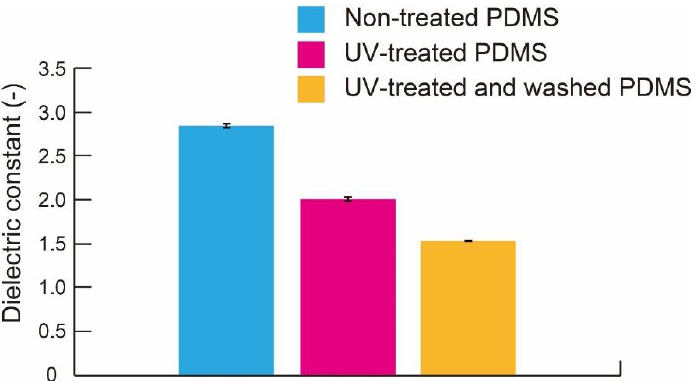
Figure 8. Dielectric constant of nontreated PDMS, UV-treated PDMS, and washed PDMS membranes (n = 20).